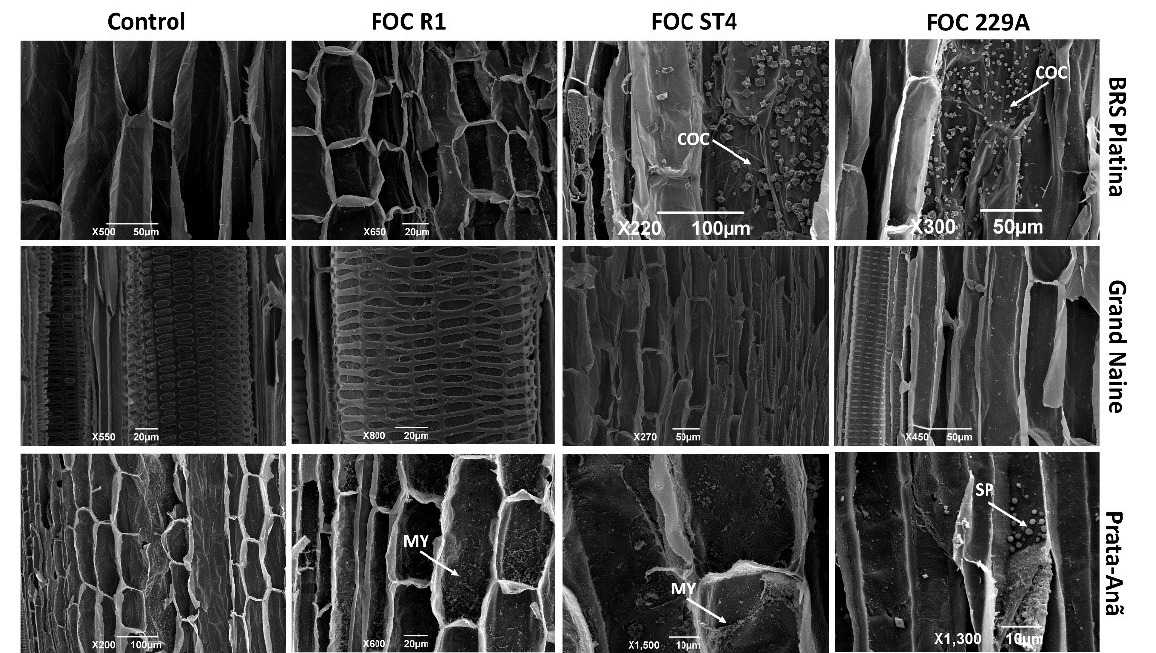
Figure 7. Scanning electron micrographs of longitudinal sections of roots of banana cultivars with xylem cavities infested by different Fusarium oxysporum f. sp. cubense isolates 48 h after inoculation (HAI). Foc: Fusarium oxysporum f. sp. cubense ; R1: race 1; ST4: subtropical race 4; COC: calcium oxalate crystals; MY: mycelium; SP: spores.